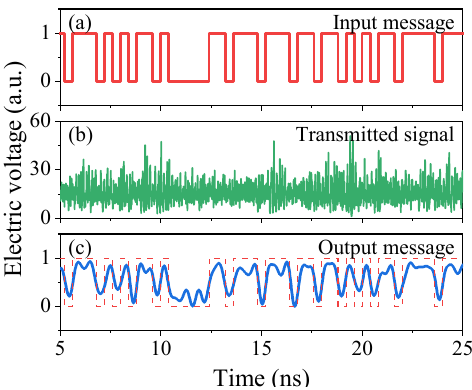
Figure 4. Illustration of message encryption/decryption processes. ( a ) The input original message, ( b ) the transmitted signal, and ( c ) the input original message (dashed) and output recovery message (solid).